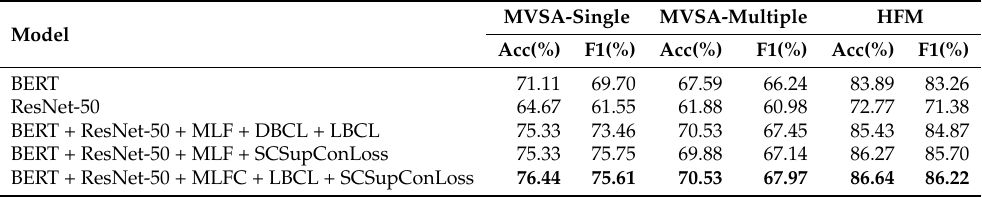
Table 4. Ablation study results. The results of our experiments are highlighted in bold.